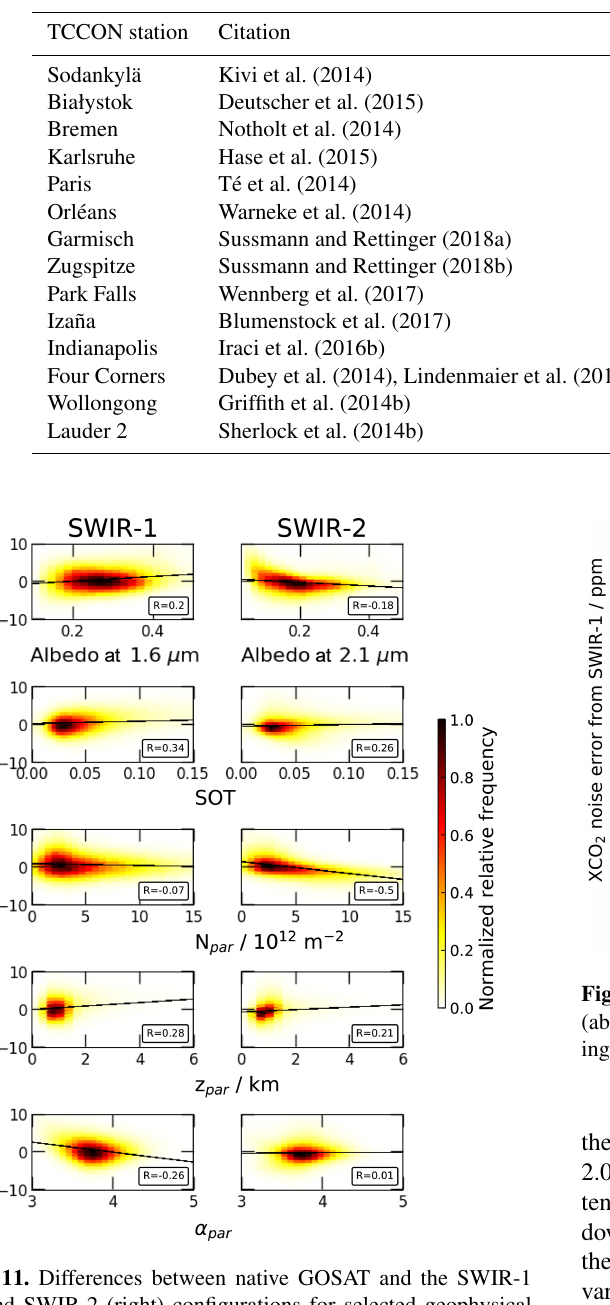
Table 2. Overview of TCCON datasets used in this work.